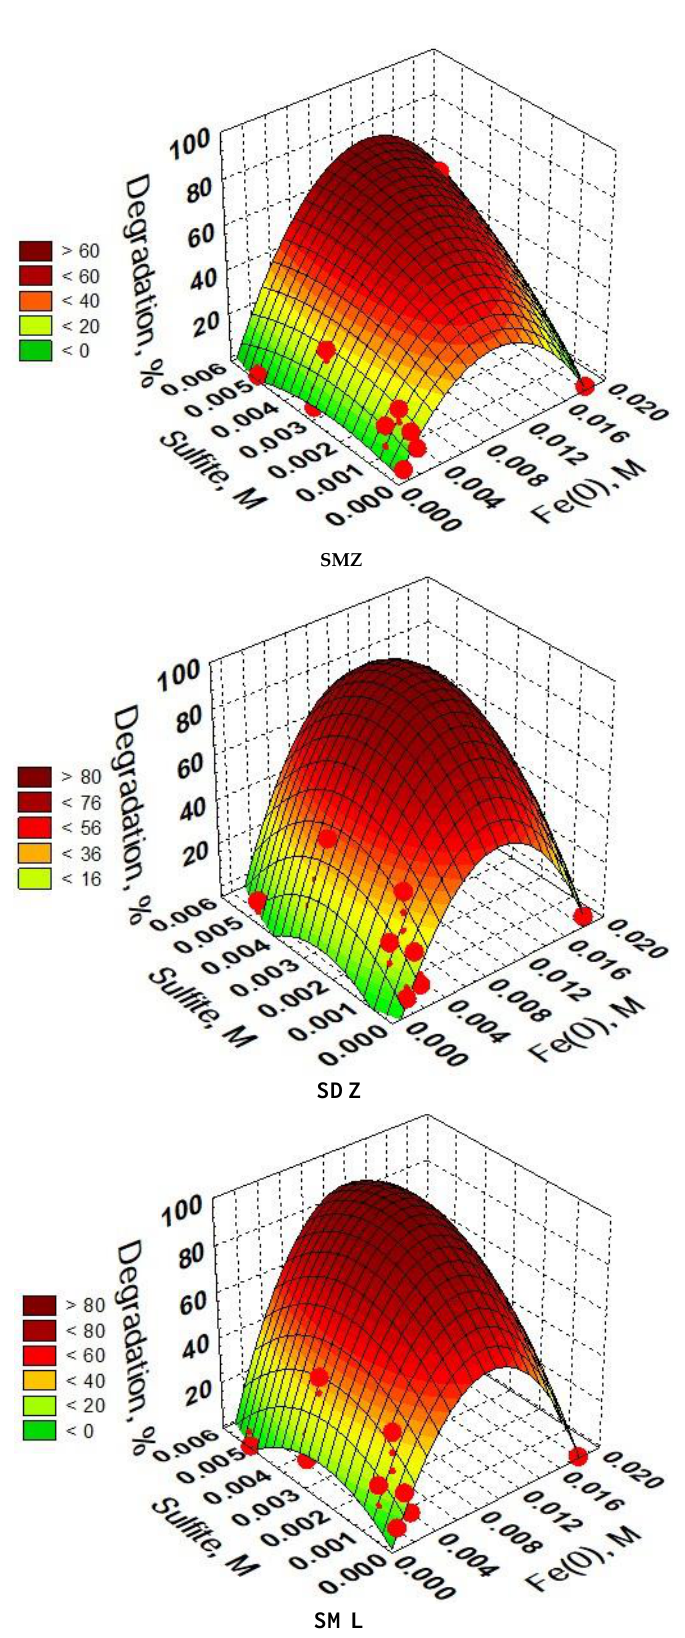
Figure 3. Response surface obtained for the degradation of 4-aminobenzene sulfonamides (SAs) as a function of Fe(0) and sulfite concentrations. [SAs] = 5.38 × 10 −5 M, [Fe(0)] = 5.37 × 10 −4 –1.79 × 10 −2 M, [sulfite] = 6.25 × 10 -5 –5.0 × 10 -3 M, pH 3, T = 298 K.